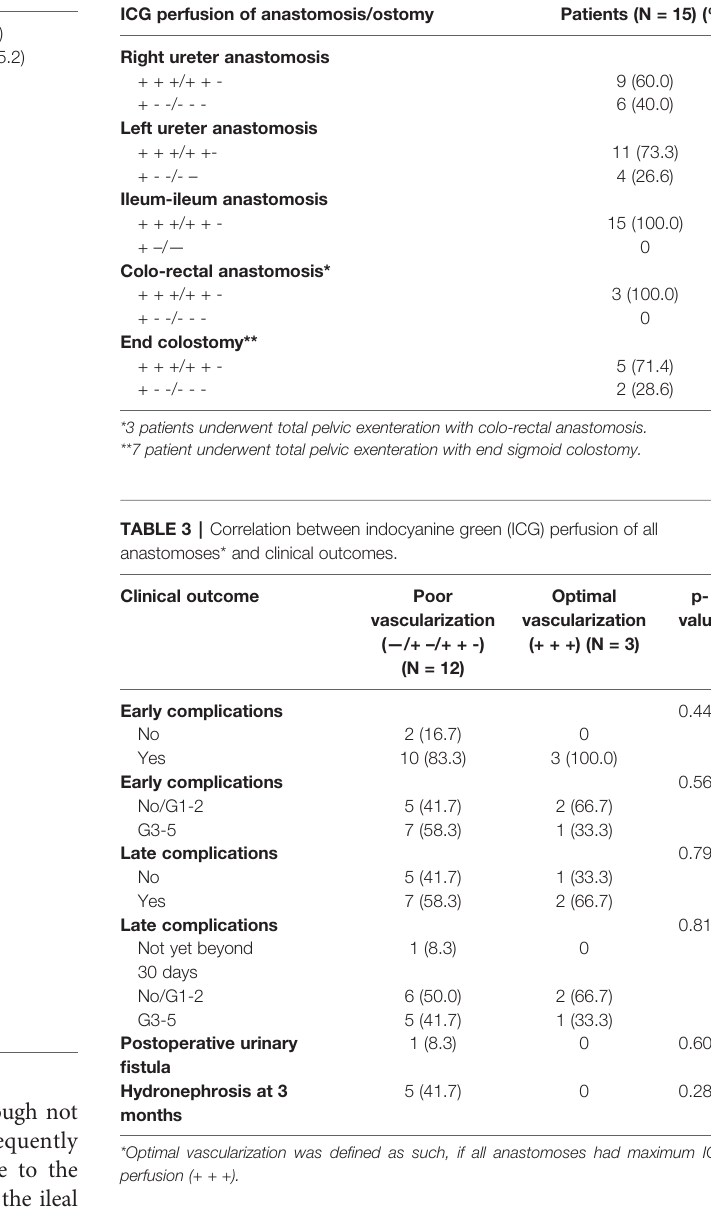
TABLE 2 | Indocyanine green (ICG) perfusion according to different anastomoses. ICG perfusion of anastomosis/ostomy Patients (N = 15) (%)